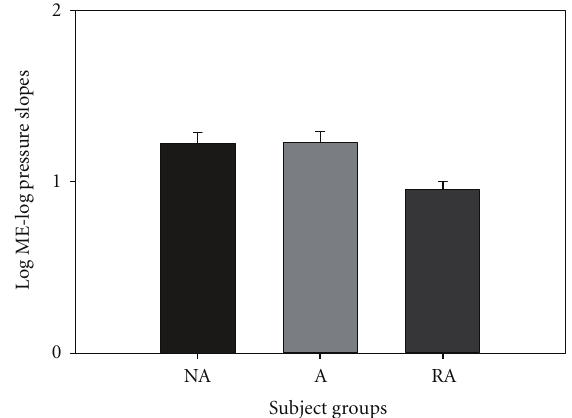
Figure 2: There was no significant di ff erence between the slopes for the 3 groups, NA, A, and LTA, for inspiratory PT load